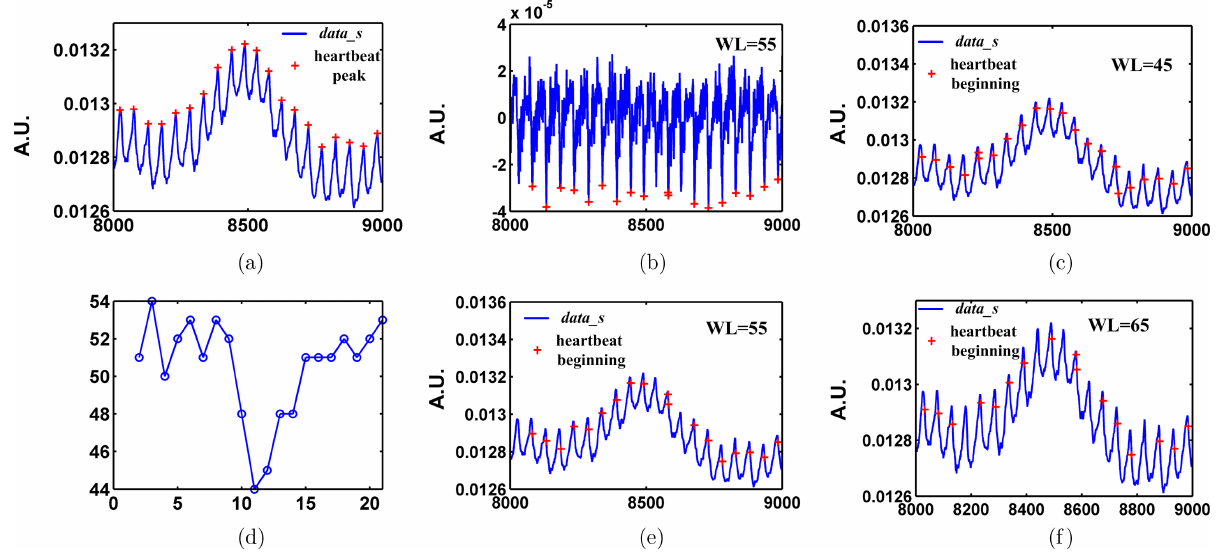
Fig. 4. Comparison between our method and the MTWM. (a) Heartbeat peaks obtained by our method, and the corresponding heart peak interval is shown in (b). (c) Minimums (red crosses) within a prede¯ned window detected by the MTWM in the smoothed time derivative of optical data. (d) Each minimum is the beginning of each heartbeat, marked in data s . (e) and (f) show detection results of the MTWM with di®erent WL. The data in (a), (d), (e) and (f) are from Sub2 Ch4 a , and the horizontal axis represents time in points